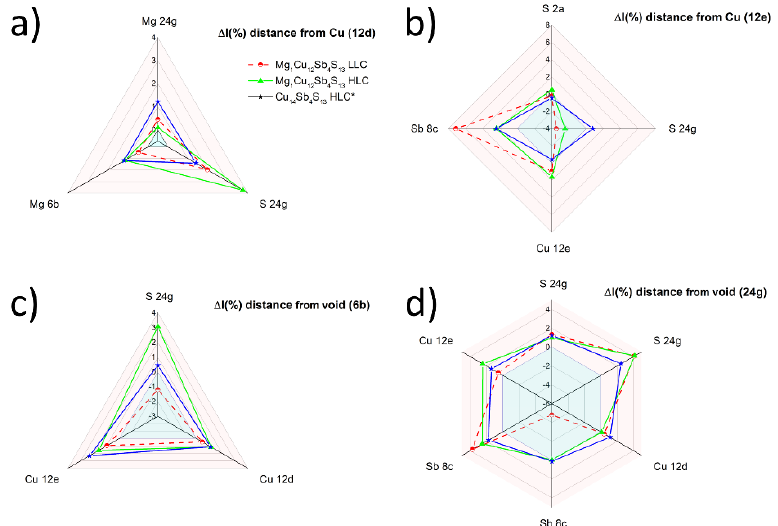
Figure 10. Plots of the relative change in bond length or distance ∆ l upon doping with Mg meas-ured at different atomic sites for Mg 1 Cu 12 Sb 4 S 13 . ( a ) Cu 12d site, ( b ) Cu 12e site, ( c ) void 6b site, ( d ) void 24g site. Results are expressed as a percentage of a given bond/distance. * Results for Cu 14 Sb 4 S 13 from